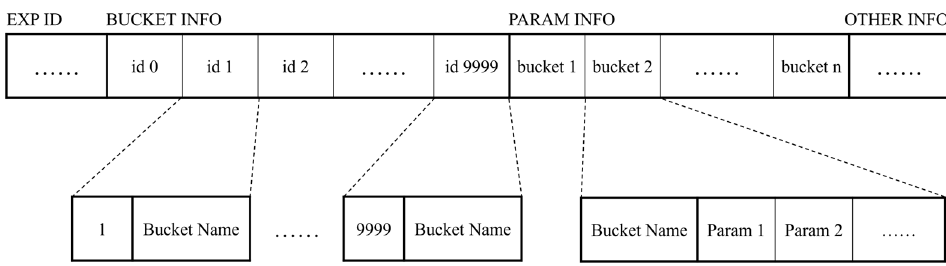
Figure 3. Strategy con fi guration information.